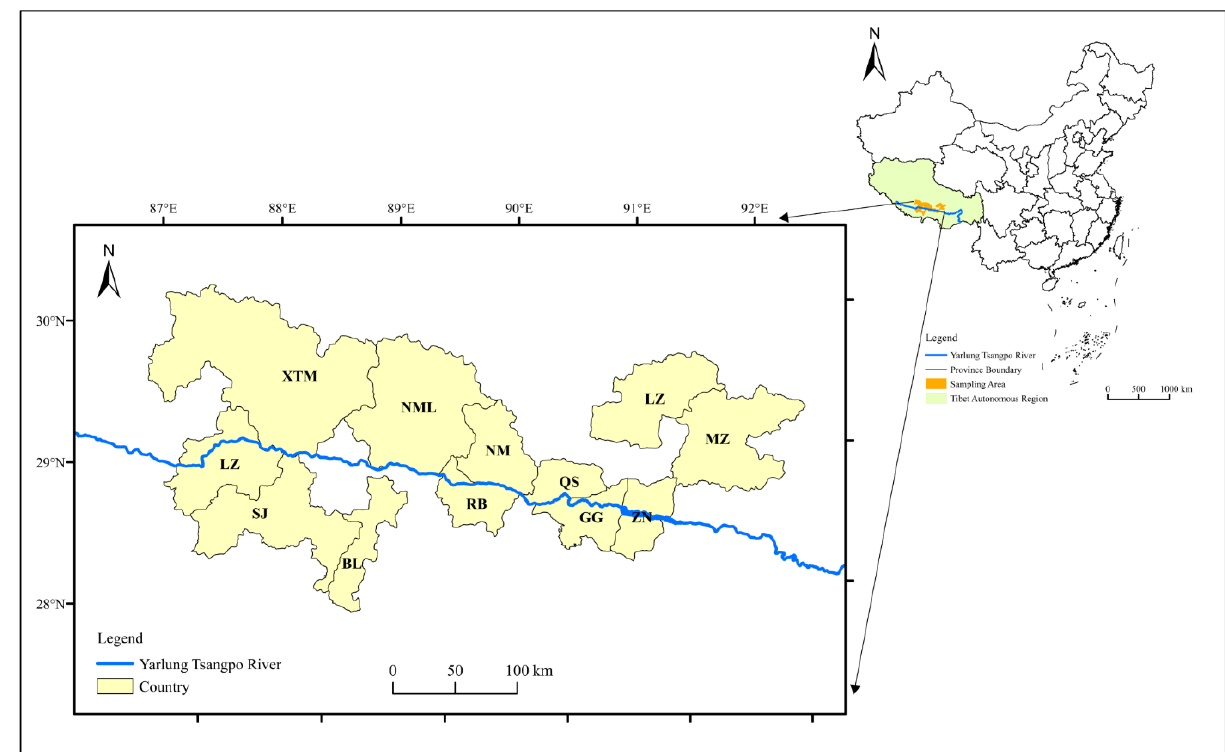
Figure 1. Distribution of sample countries.